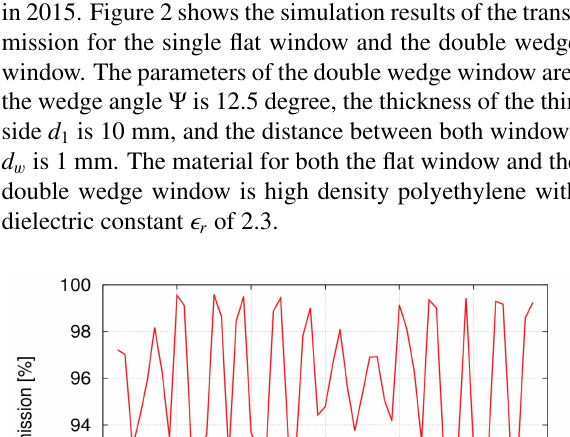
Figure 3. The layout of the transmission line (TL) in the diag- nostic